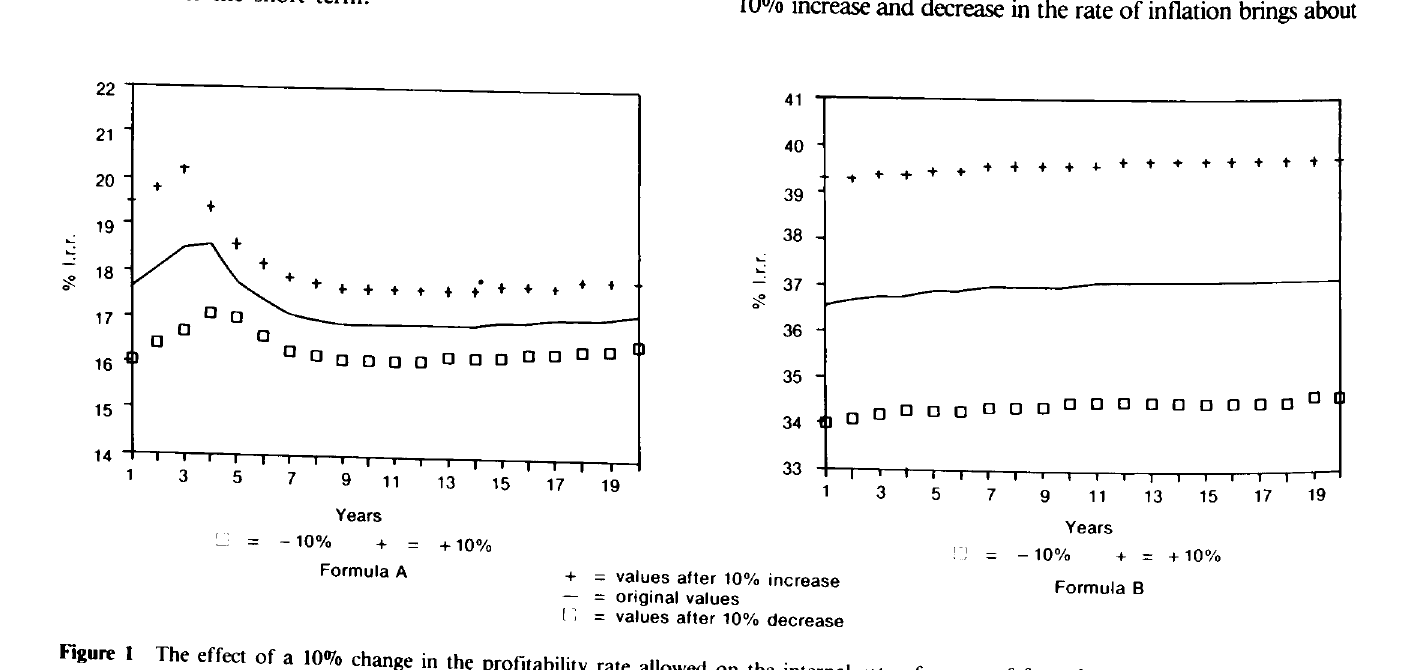
Figure 1 The effect of a 10% change in the profitability rate allowed on the internal rate of return of fonnulae A and